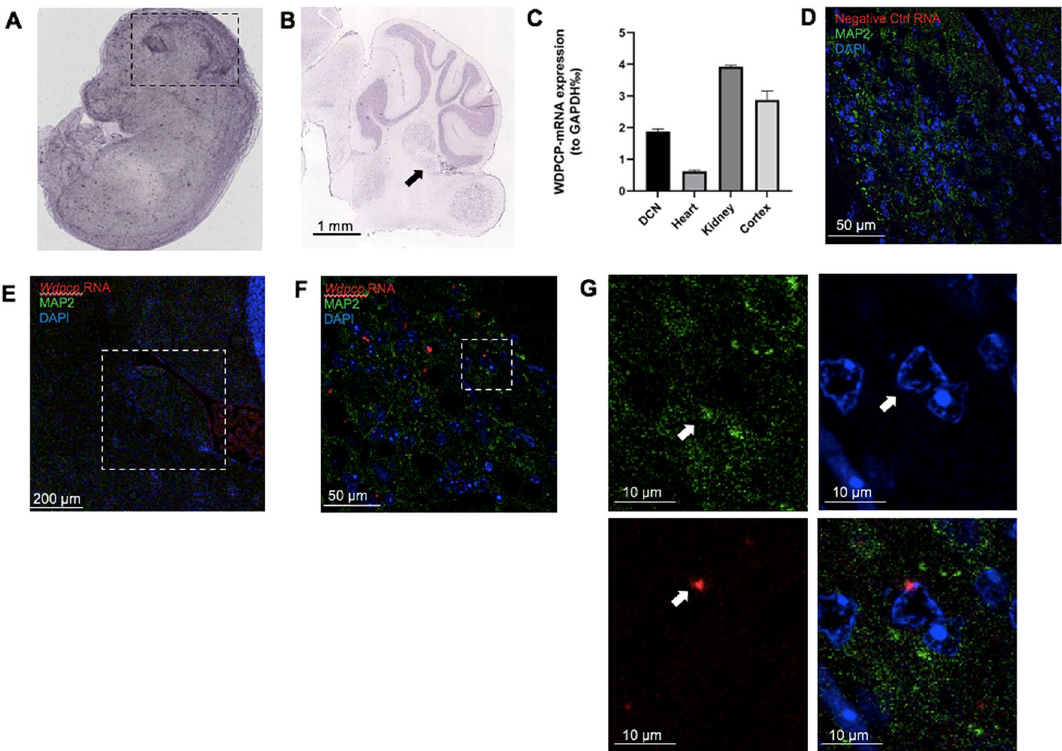
Figure 4. Wdpcp is expressed in the murine dorsal cochlear nucleus. In situ hybridization in an ( A ) 14.5 days post-conception mouse and ( B ) a C57BL/6 J mouse at P56 shows moderate expression of Wdpcp within the brain and DCN compared to surrounding tissues. The embryonic brain is demarcated by black dotted lines, while the DCN in the adult in situ data is marked by a black arrow. Quantification of Wdpcp RNA expression in a 2-month-old mouse shows relatively equivalent amounts in both the dorsal cochlear nucleus and cortex ( C ). Immunofluorescent imaging in 3-month-old mice combined with RNAScope shows colocalization of Wdpcp RNA in neurons (n = 5). Negative controls treated with a zebrafish slc17a8 probe at 40 × magnification ( D ). The DCN is outlined in white in the 10X panel ( E ). Images at 63 × show distinct Wdpcp RNA puncta ( F ). Enlargements of the space enclosed in the white box in panel F show colocalization of Wdpcp RNA in nuclei surrounded by MAP2 ( G ). White arrows denote location of MAP2 expression, nucleus of interest, and